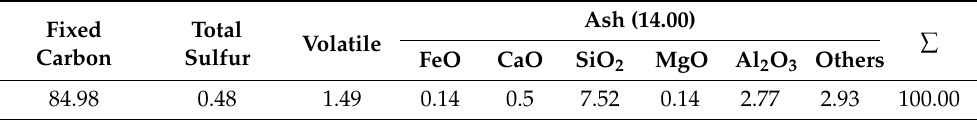
Table 2. Industrial analysis of coke breeze and chemical composition of the ash (mass,